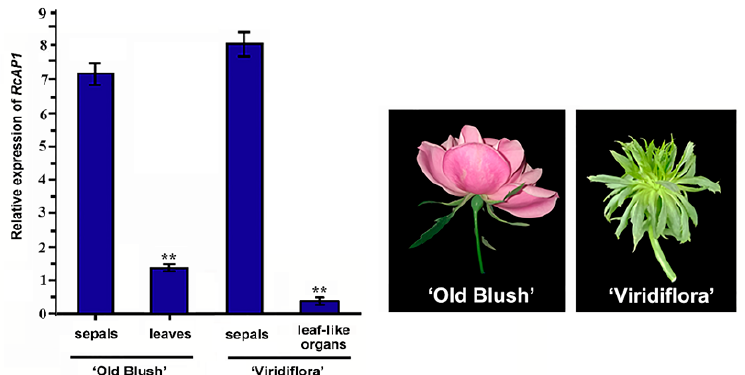
Figure 5. Quantitative analysis of RcAP1 expression in ‘Old Blush’ and ‘Viridiflora’ plants. Asterisks indicate significant differences ( p < 0.01) according to Dunnett’s test. Error bars represent the standard deviation.